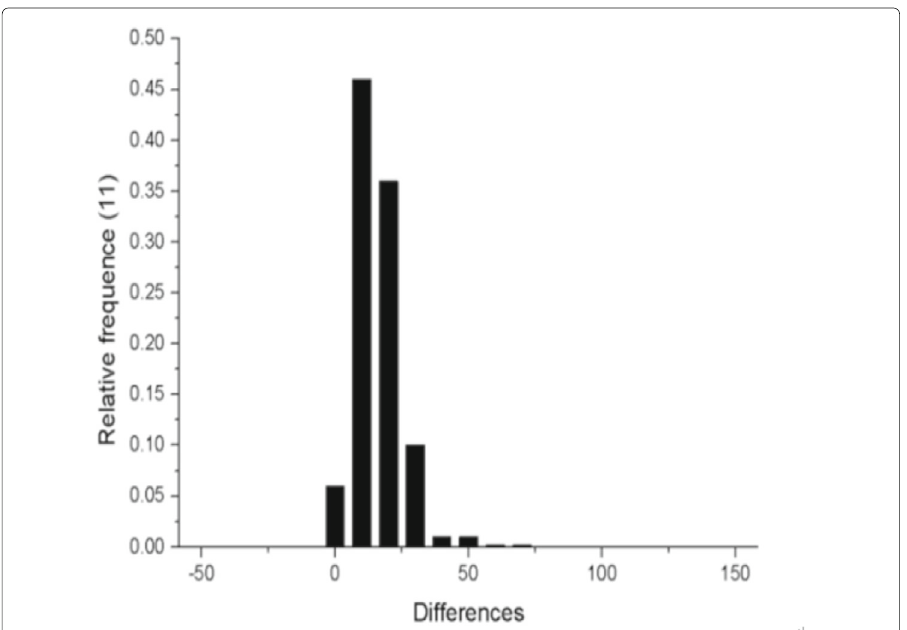
Fig. 4 The difference between exact counting and probabilistic counting of Count-Mean-Min